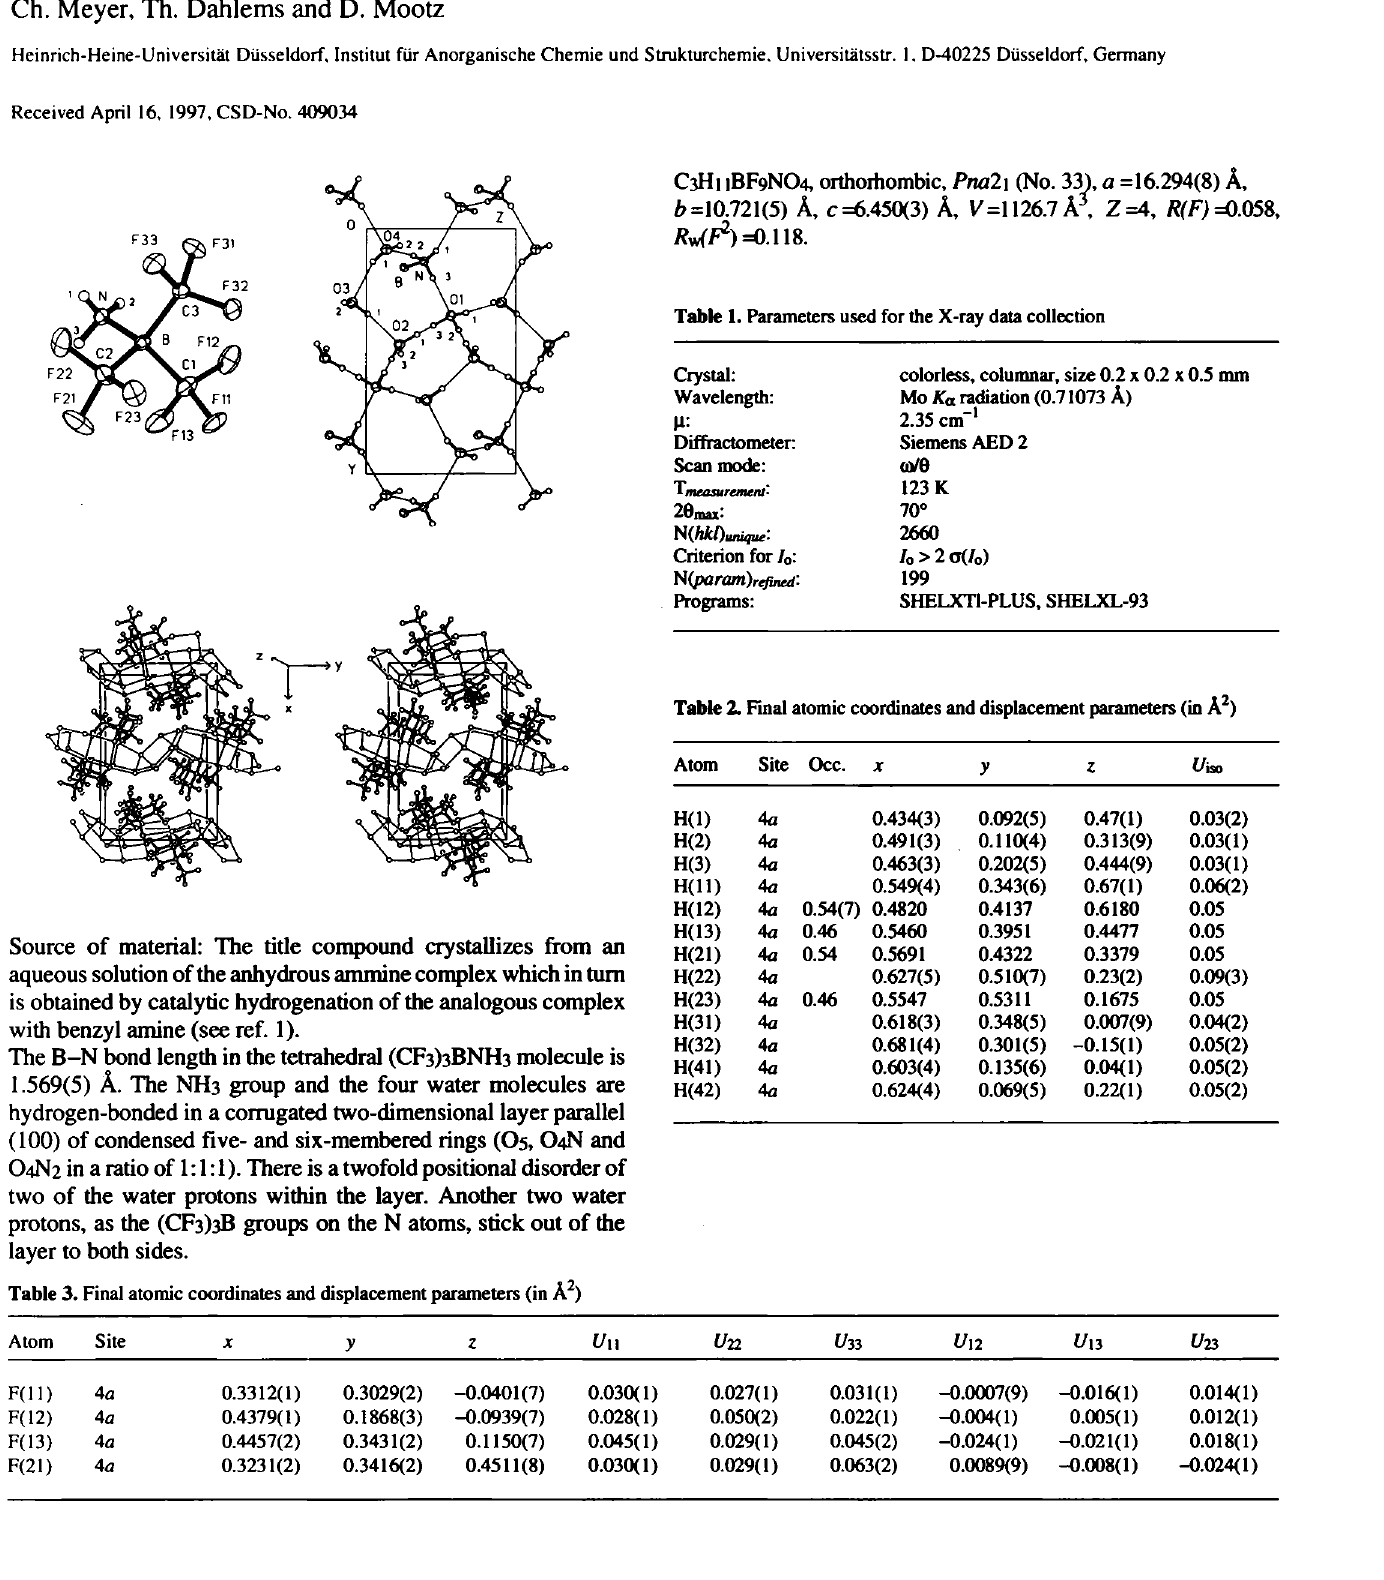
Table 3. Final atomic coordinates and displacement parameters (in Â^)